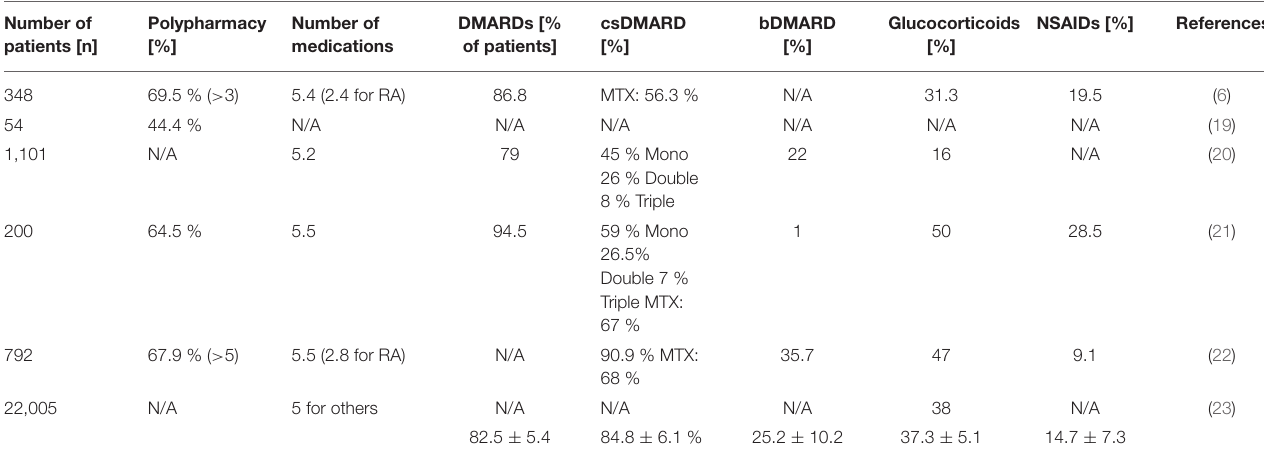
TABLE 2 | Polypharmacy, total number of medications, and frequency of prescribed RA-related medications (DMARDs, glucocorticoids and NSAIDs) in the literature. Number of patients [n]